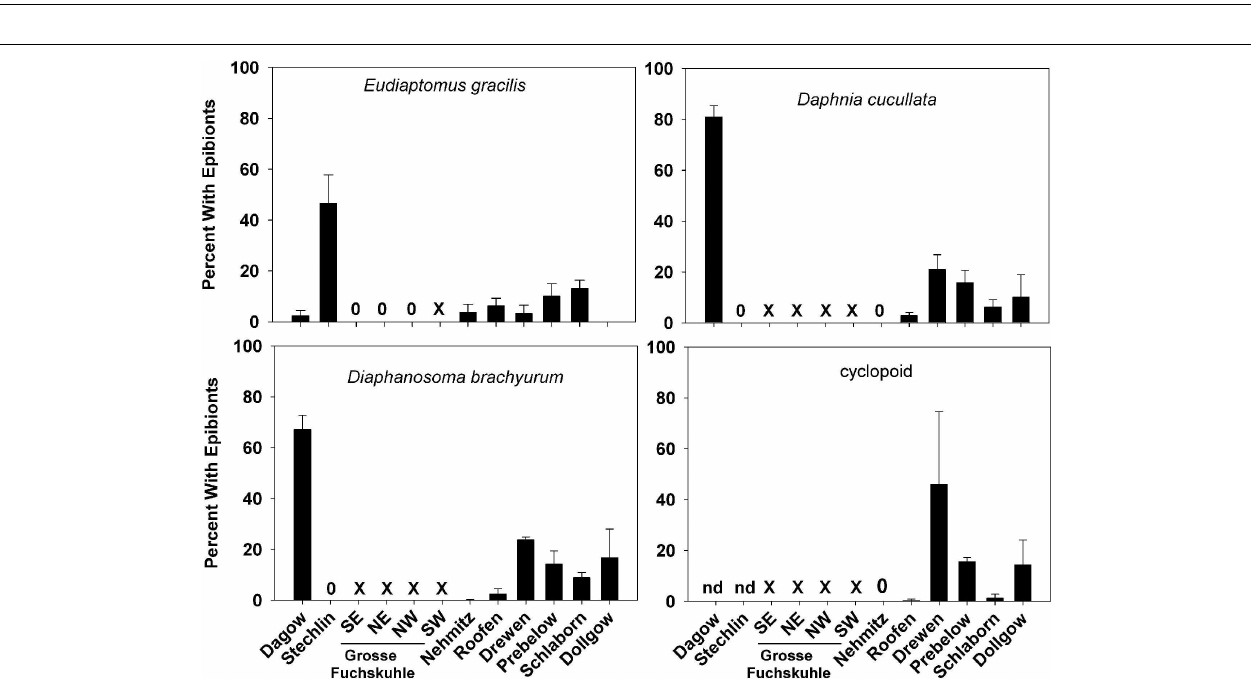
FIGURE 3 | Prevalence of ciliate epibionts (percent of the zooplankton population with one or more ciliate epibionts; mean ± SD, n = 3) on common zooplankters Eudiaptomus gracilis , Daphnia cucullata ,